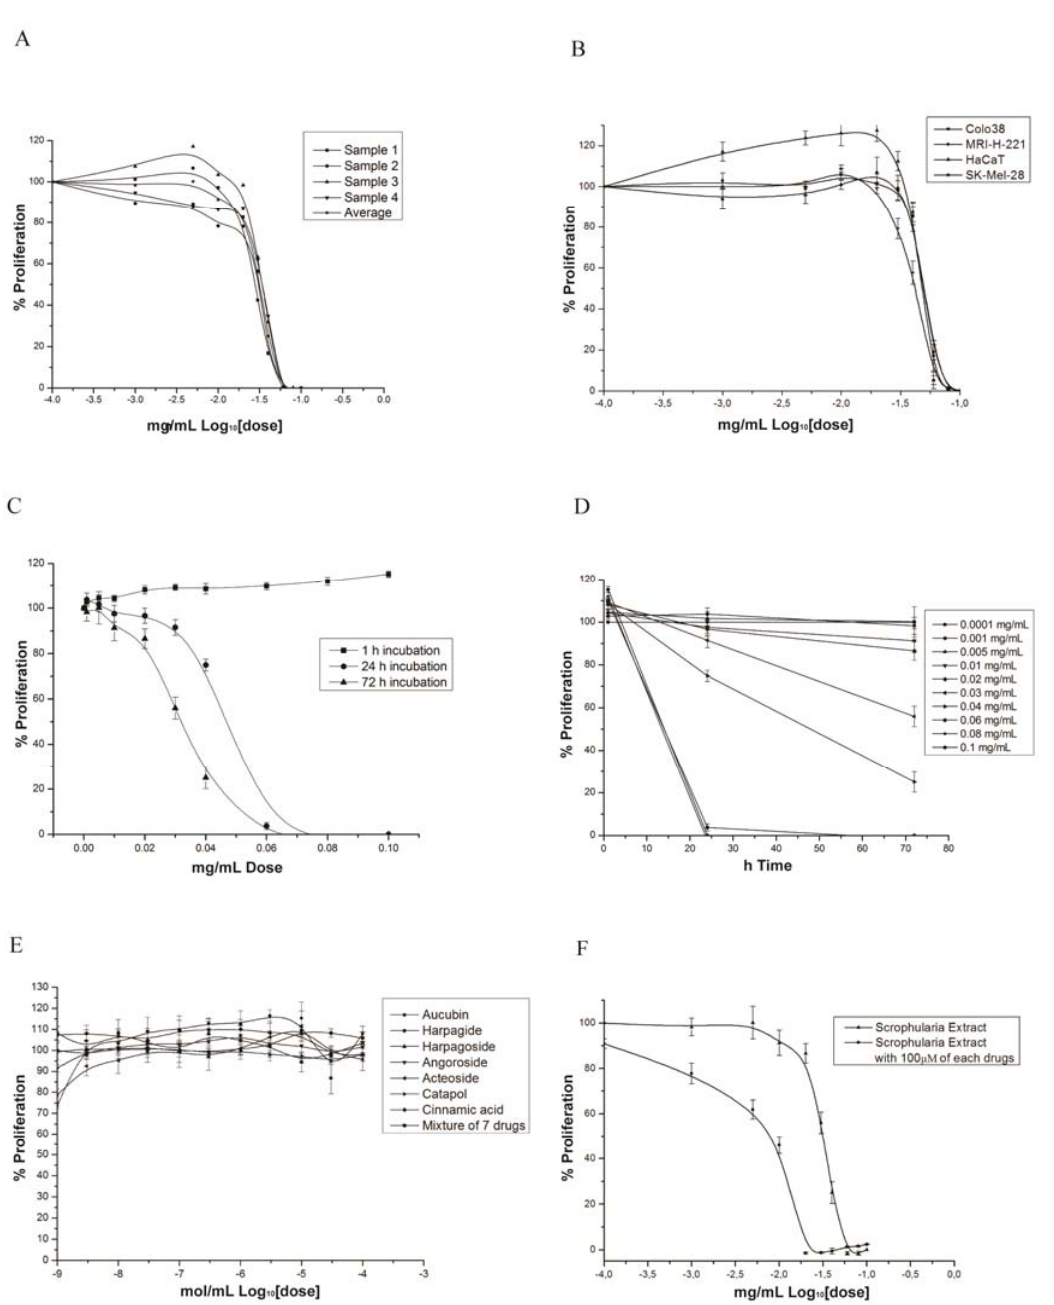
Figure 2. Cytotoxicity of Radix Scrophulariae ningpoensis as measured by XTT